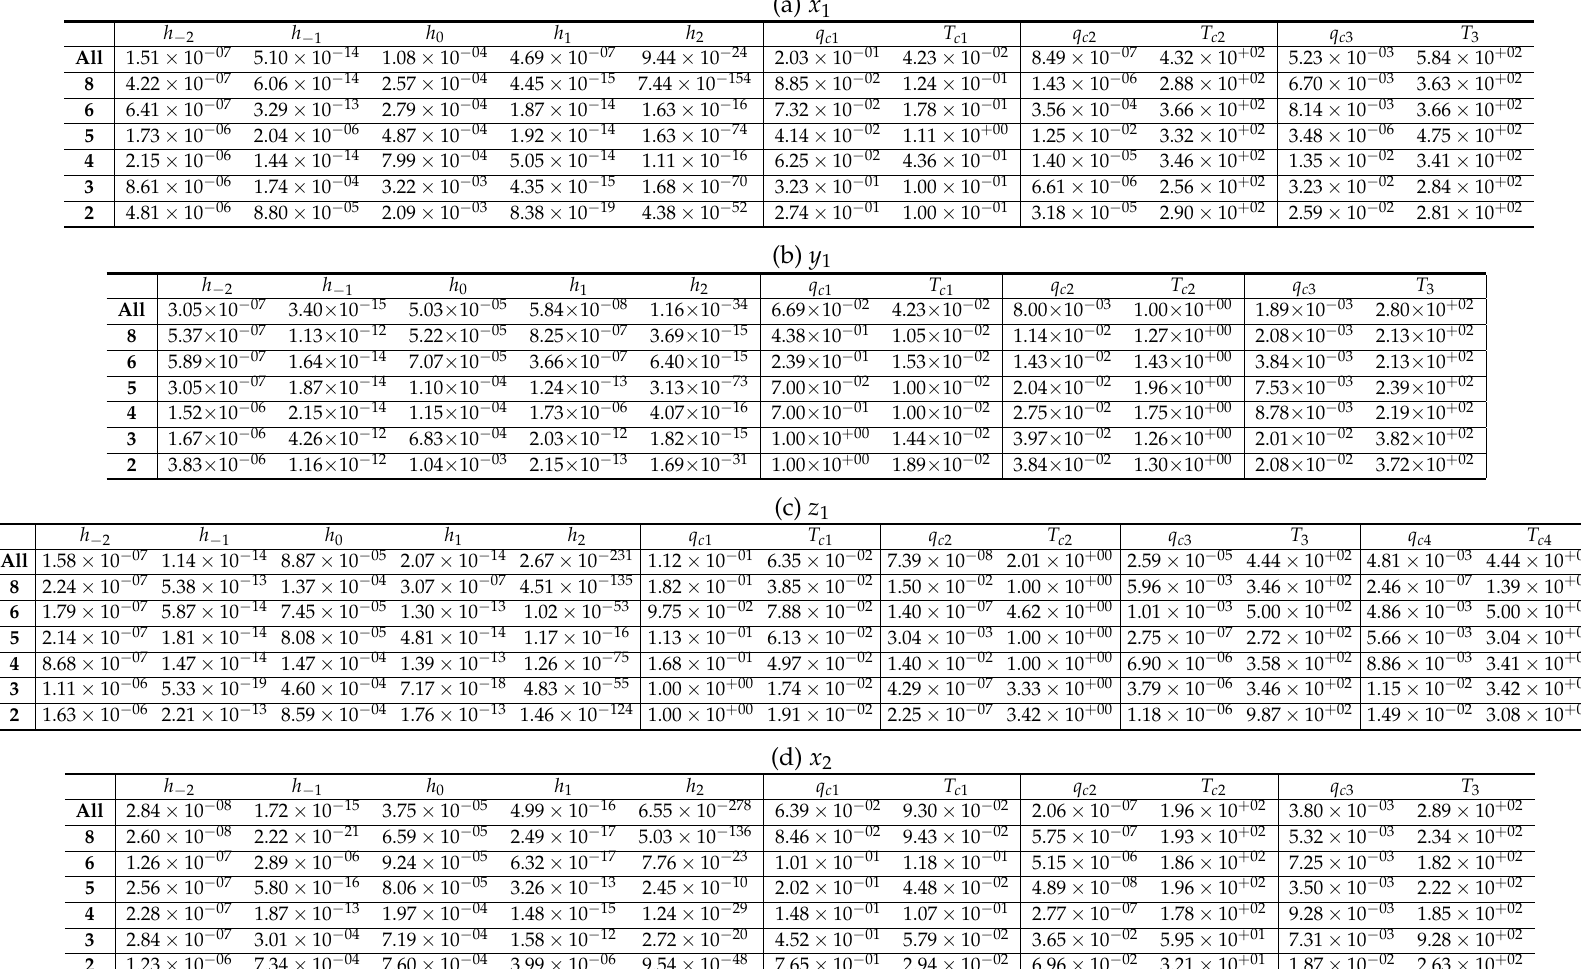
Table A2. Estimated noise parameters of Bonita cameras type for 2..10